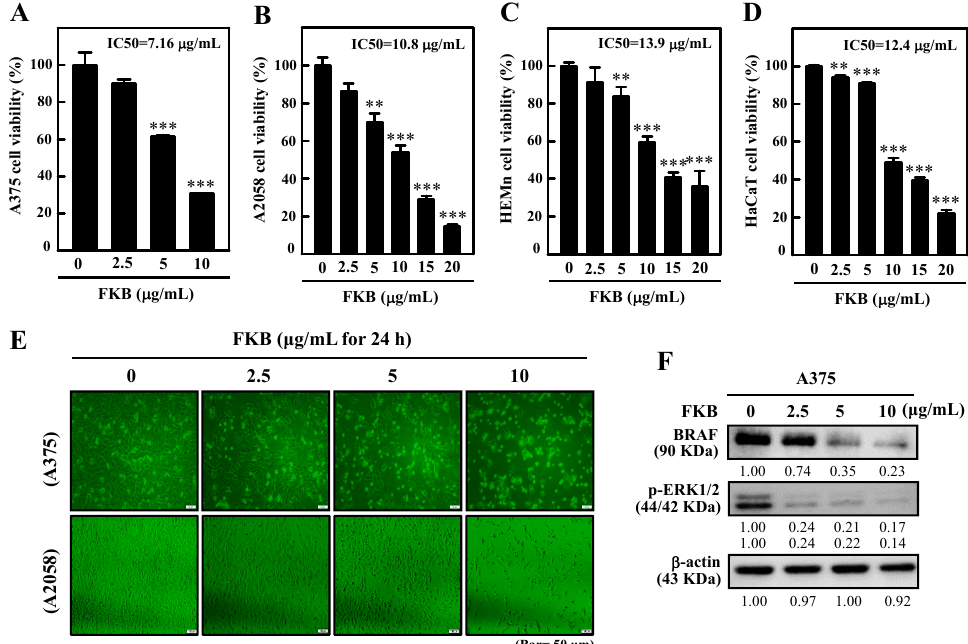
Figure 1. Flavokawain B (FKB) inhibited the growth of human melanoma cells. ( A – D ) human epithelial melanoma cell line A375, human skin lymph node derived melanoma cell line A2058, human primary epidermal melanocyte cell line (HEMn), and human skin keratinocyte cell line (HaCaT) cells were exposed to 0–20 µ g / mL concentrations of FKB for 24 h. Then, 3-(4,5-dimethylthiazol-2-yl)-2,5-diphenyltetrazolium bromide (MTT) assay was carried out to determine cell viability. The IC 50 value for each cell type was determined as described in the methods section (inset: IC 50 values of respective cell lines). ( E ) FKB mediated morphological changes in A375 and A2058 cells were examined using the phase-contrast microscope. ( F ) Expression patterns of BRAF and p-ERK proteins were determined by Western blot to discover the e ff ect of FKB concentrations (0–10 µ g / mL) for 24 h. β -actin was used as an internal control. Each value was expressed as mean ± standard deviation of three experiments. Statistical significance was assigned as ** p < 0.01 and *** p < 0.001 as compared to the untreated control